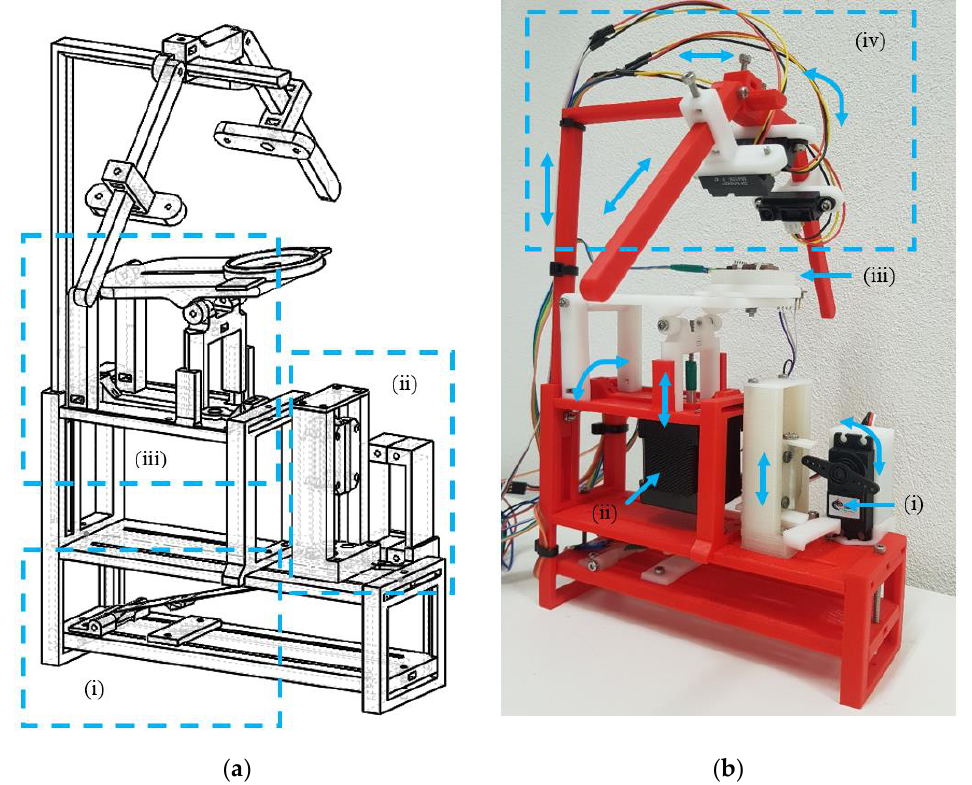
Figure 1. Mechatronic device for the physical simulation of the abdomen displacement: ( a ) schemat- ics of the mechatronic platform, ( i ) vibration noise detector module, ( ii ) hammer module with adjustable energy, ( iii ) human motion/position simulator module; ( b ) 3D printed mechatronic plat- form, ( i ) servomotor, ( ii ) stepper motor, ( iii ) soft printed composite disc for the simulation of the physical response of clothes, ( iv ) infrared sensor support pole.